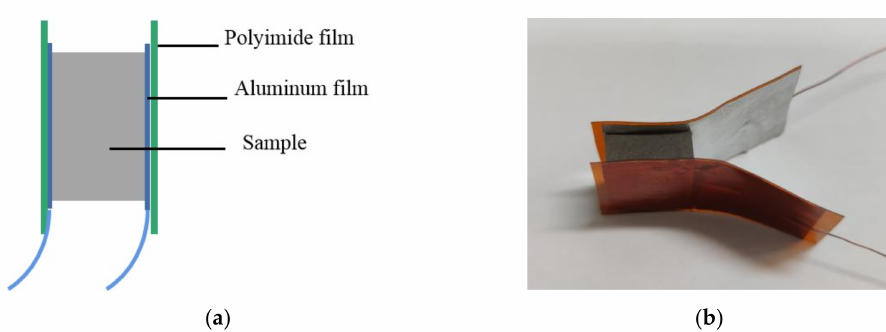
Figure 2. Packaged structure of the sample. ( a ) Schematic of the packaged structure; ( b ) Actual image of the packaged